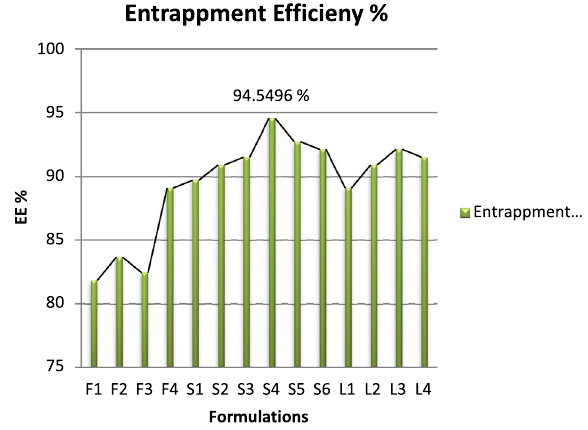
Figure 1. Graphical representation of EE results.